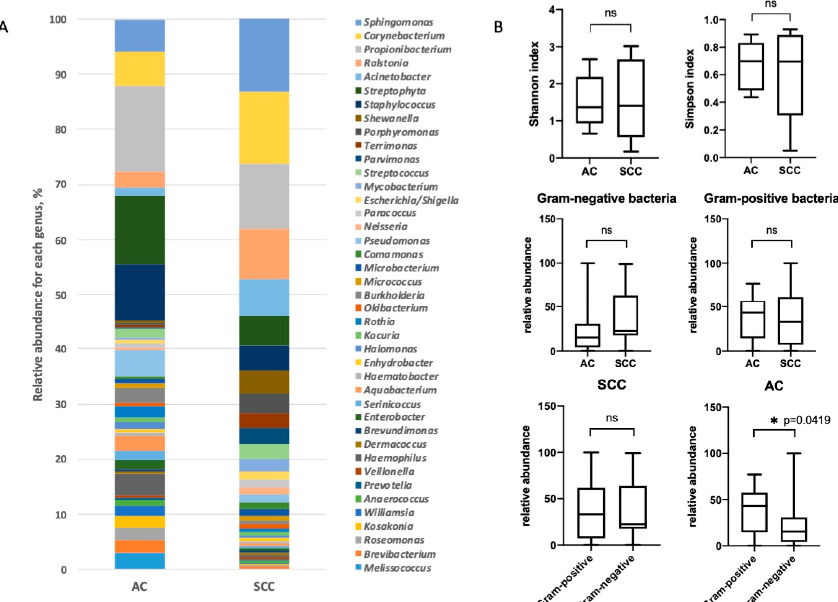
Figure 3. Taxonomic composition of the microbial communities at the genus level in lung tumors of different histological types. ( A ). Relative abundances of the dominant bacterial genera in the microbiota of adenocarcinoma (AC) and squamous cell carcinoma (SCC) groups ( B ). The alpha diversity was calculated with Shannon and Simpson indices for the AC and SCC groups. The percentage of Gram-positive and Gram-negative bacteria in groups of different histological types is shown (*- statistically significant).